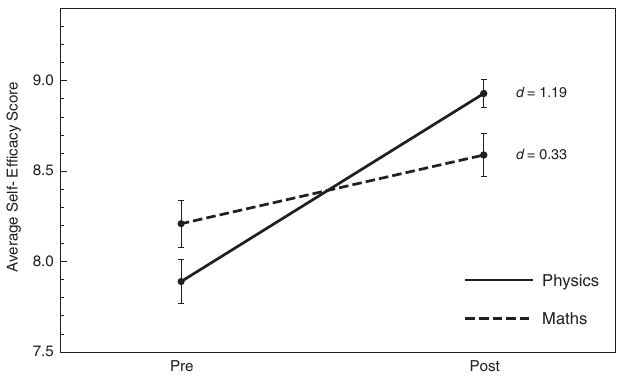
FIG. 6. Mean self-efficacy pre- and postsurvey ratings for all 79 students, grouped by statement topic (physics, shown by the solid line, and those not covered, in this case math, shown by the dashed line). Marks shown represent the average rating per statement, on a 10-point Likert scale. The error bars represent the standard error of the